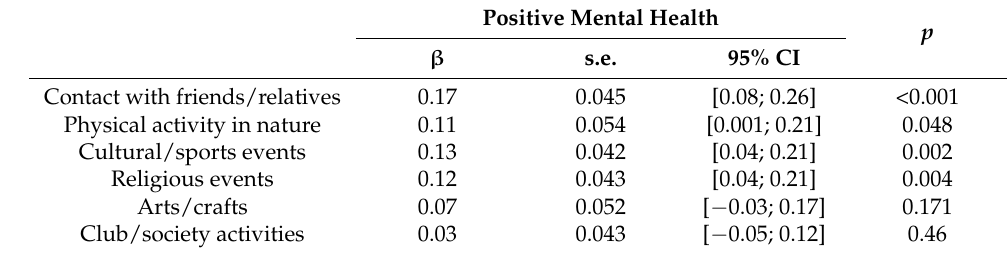
Table 2. Direct standardised paths from leisure activities to positive mental health in the main model ( n = 801), controlling for all circumstantial factors (in Table 3).